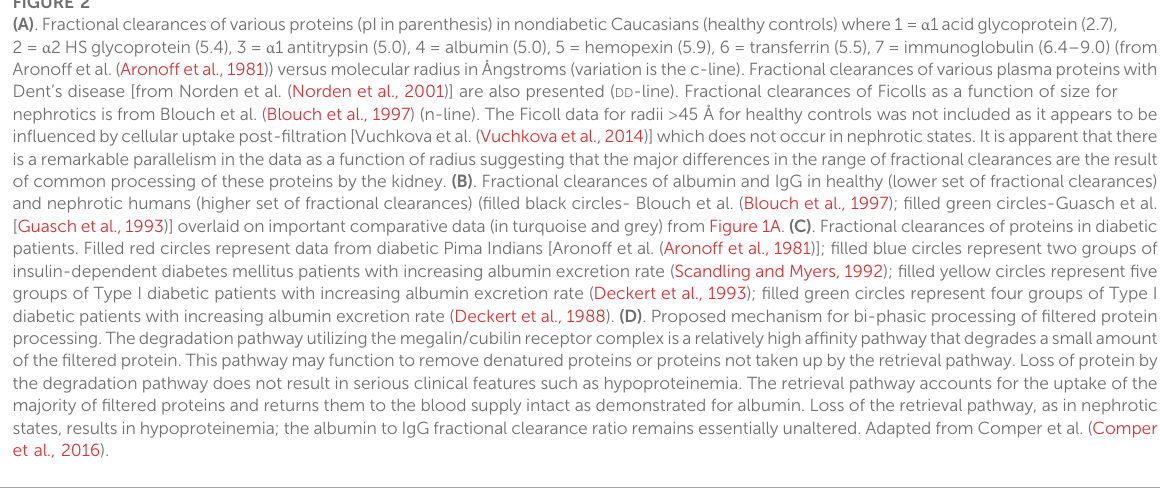
Figure 2D features the proposed by bi-phasic nature of albuminuria/proteinuria associated with the degradation pathway and retrieval pathway. Filtered proteins are retrieved by the retrieval pathway and returned to the blood supply. Small quantities ( < 5%) not retrieved undergo degradation by the